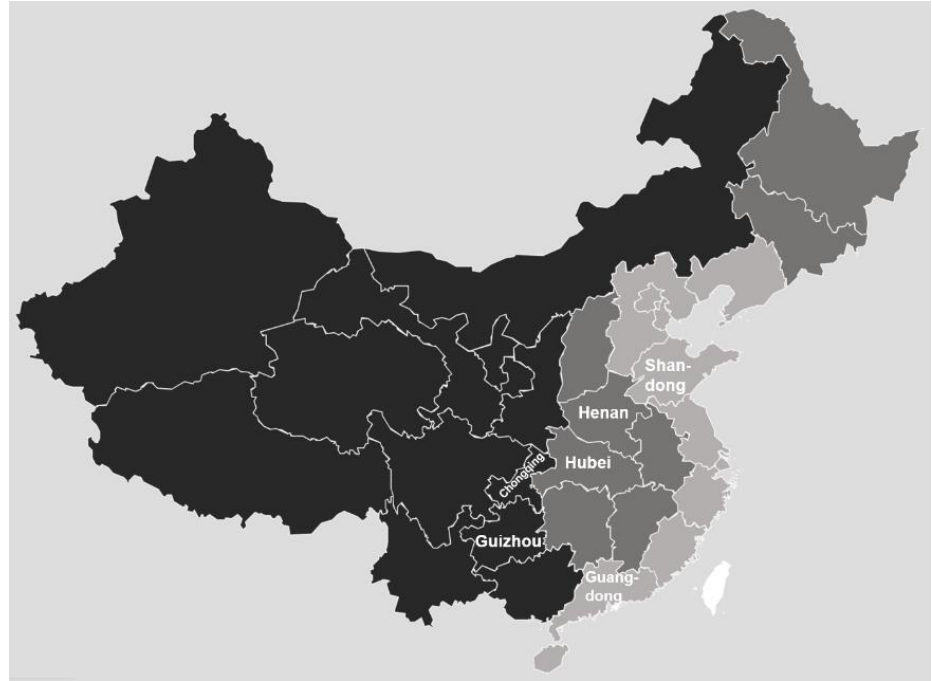
Figure 1. Sample provinces.